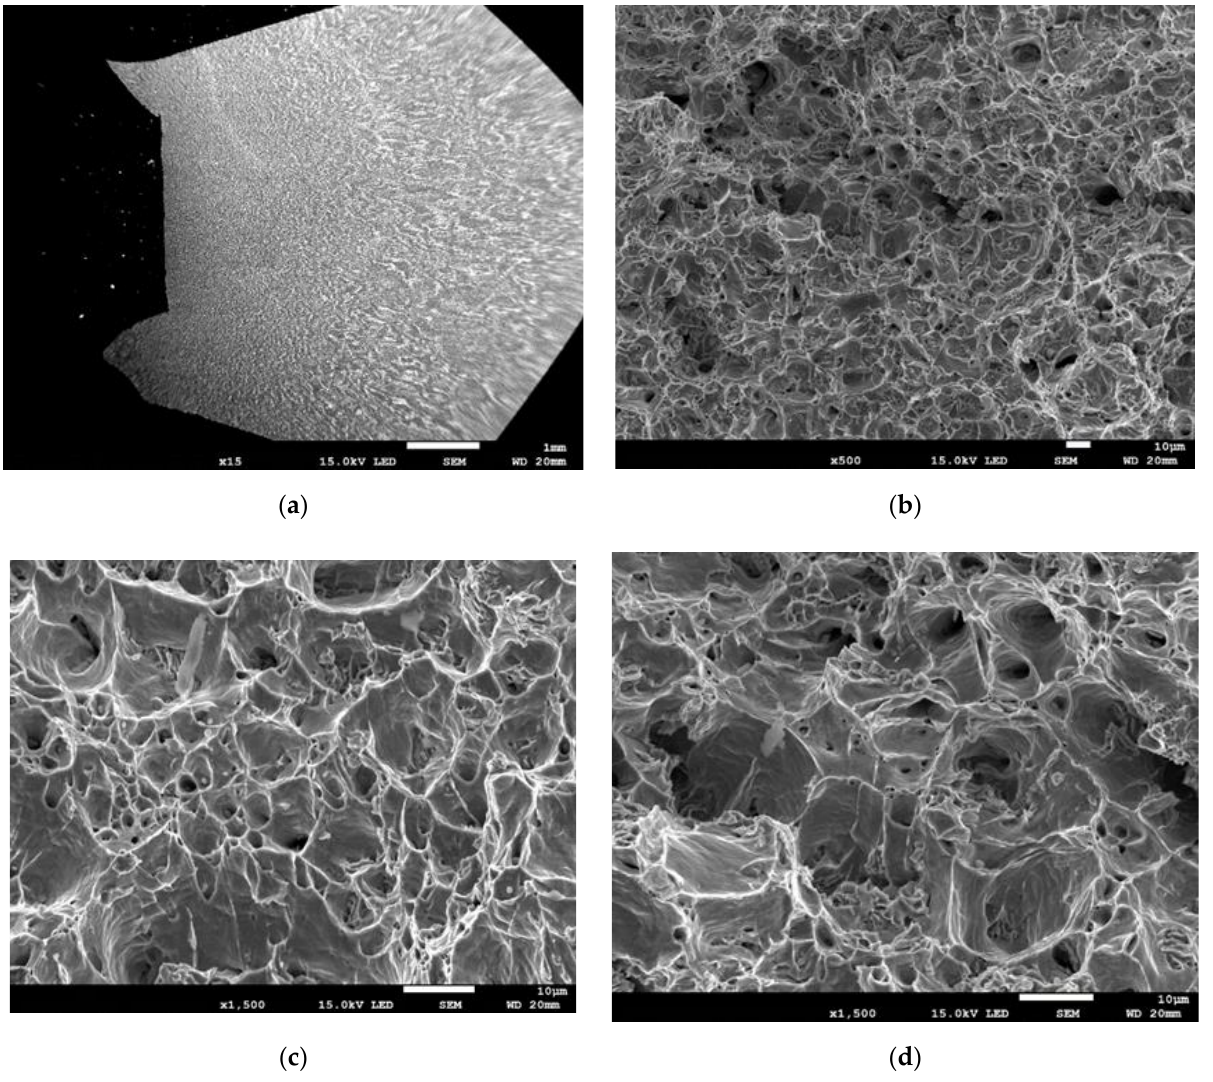
Figure 9. ( a ) Macro view of specimen microstructure nearest the fracture plane (picture across the thickness); ( b – d ) fracture relief of specimen breakthrough in the central part of the specimen (normal oriented pictures).